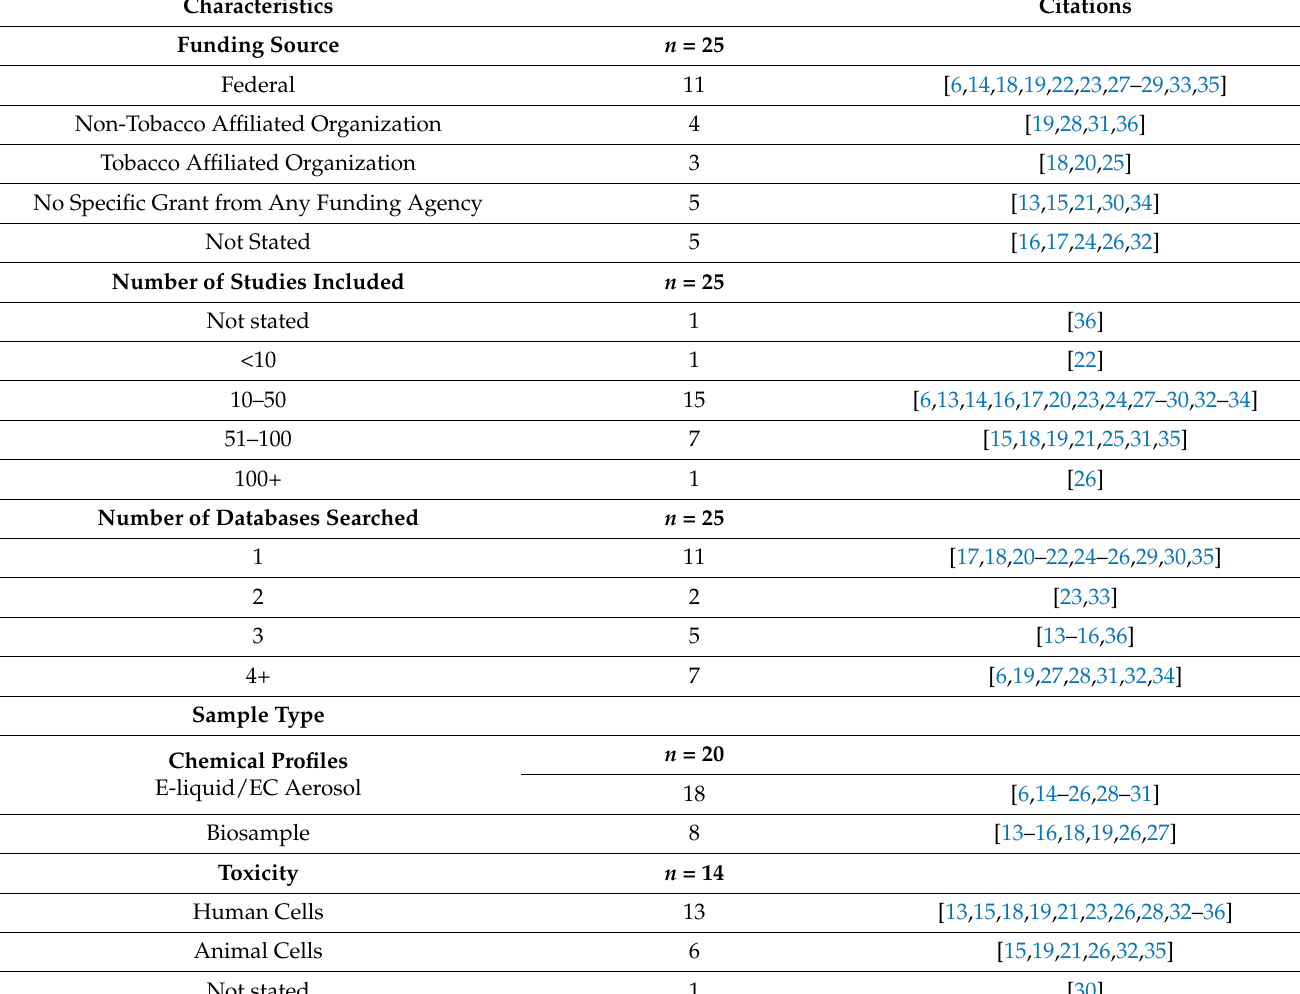
Table 1. Characteristics of Included Systematic